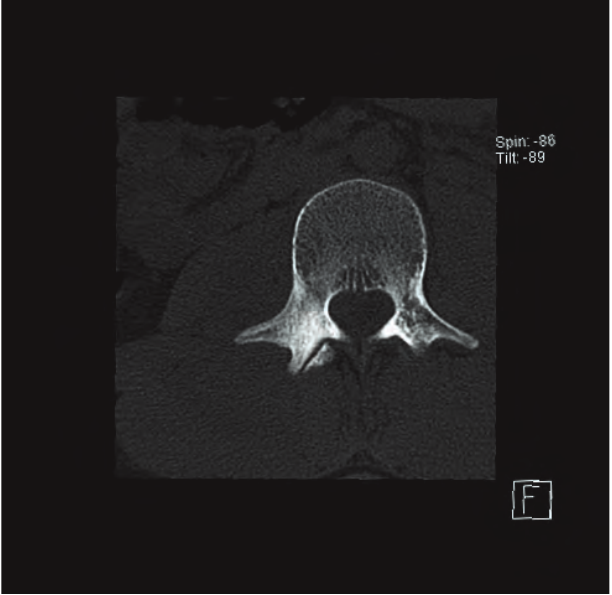
Fig. 2. A selected L3 axial CT slice (bony window). Note the sclerosis and smooth volumetric expansion of the the right pedicle.